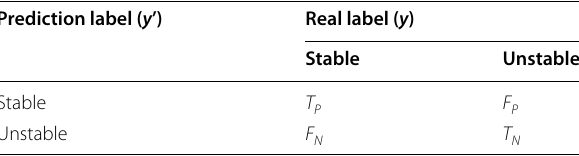
Table 1 The confusion matrix Prediction label ( y ’) Real label ( y ) Stable Unstable Stable T P F P Unstable F N T